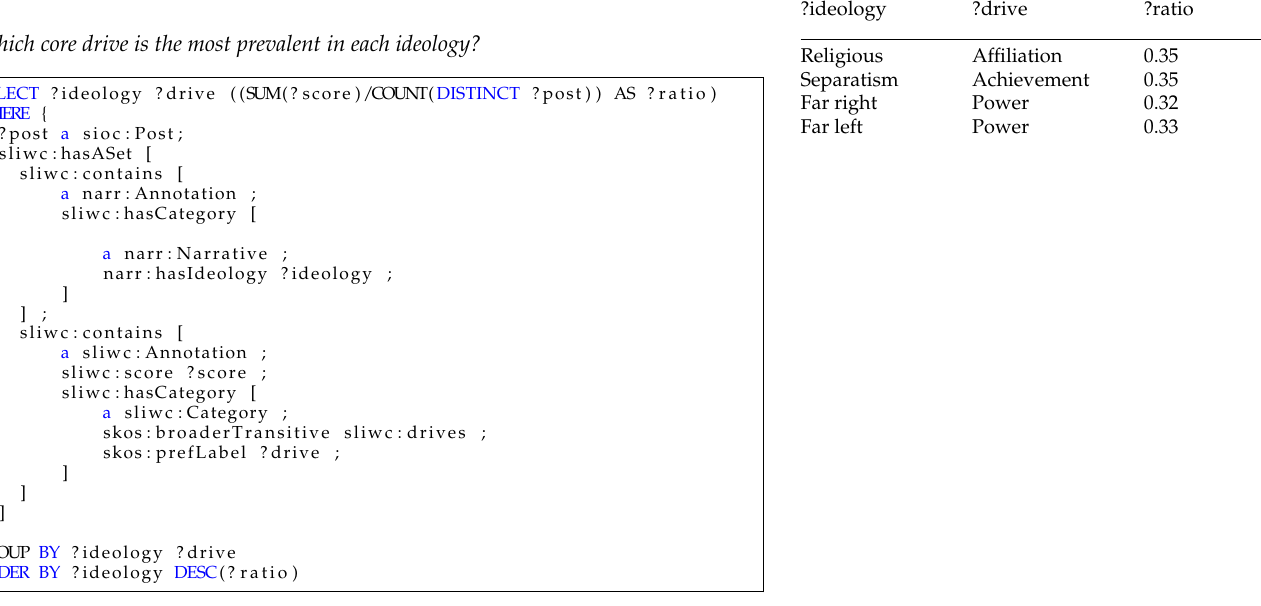
Table 7. Competency